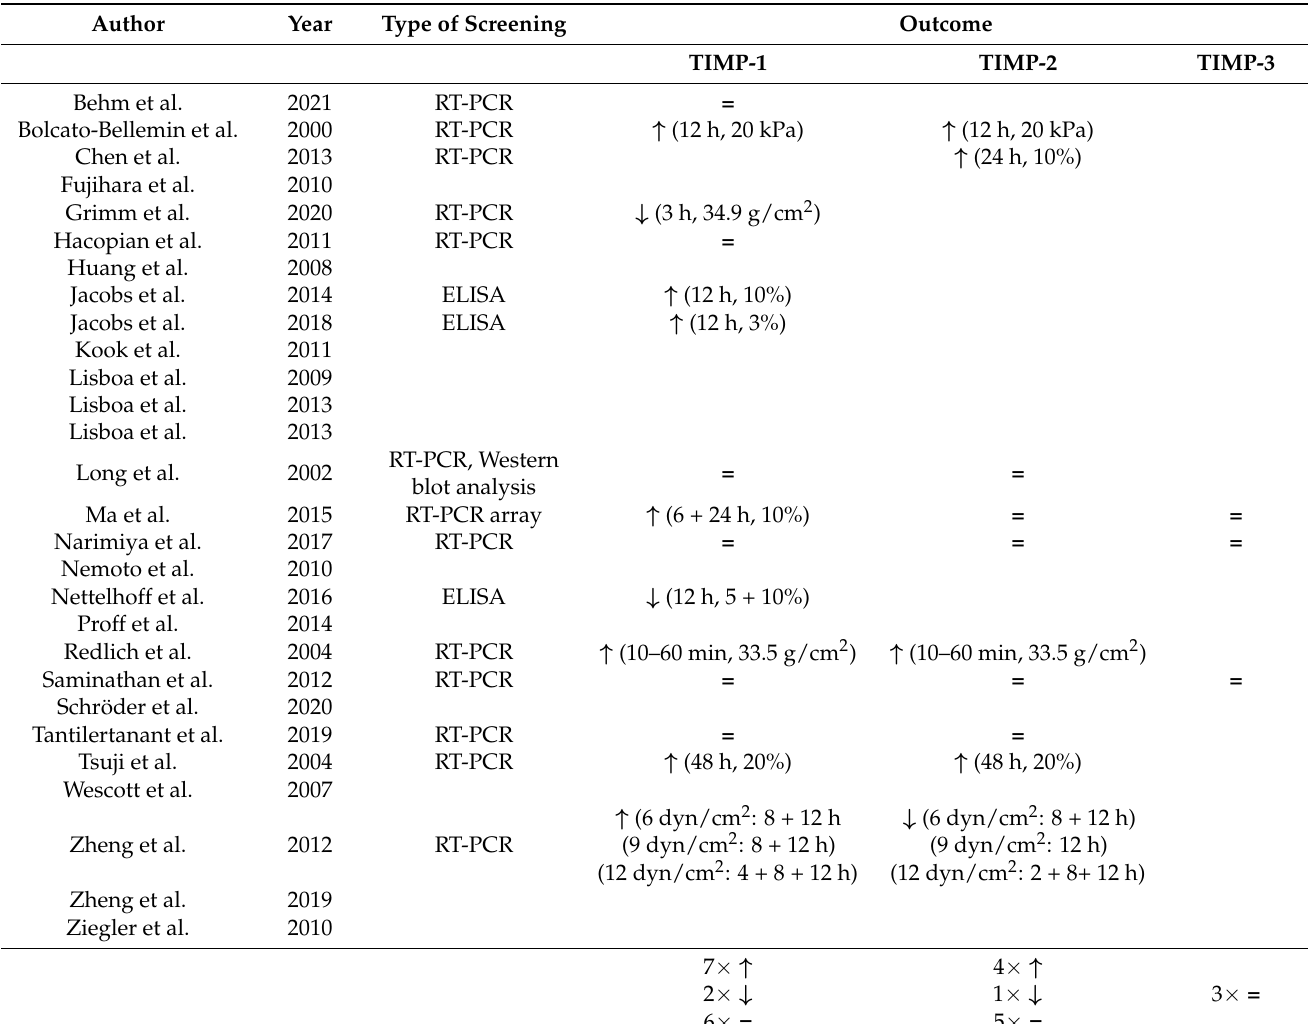
Table 4. TIMPs outcome from all included in vitro